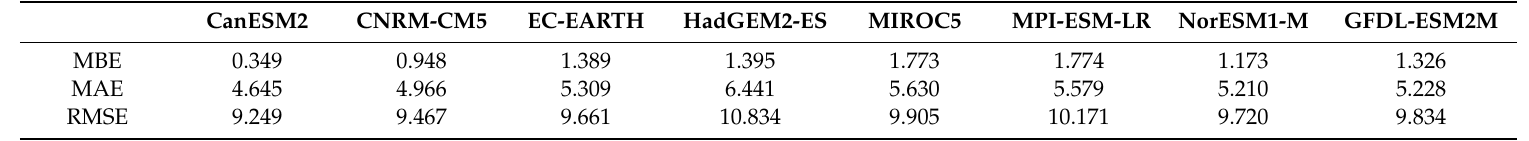
Table 6. Mean values of MBE, MAE and RMSE between observed and simulated precipitation by models for all